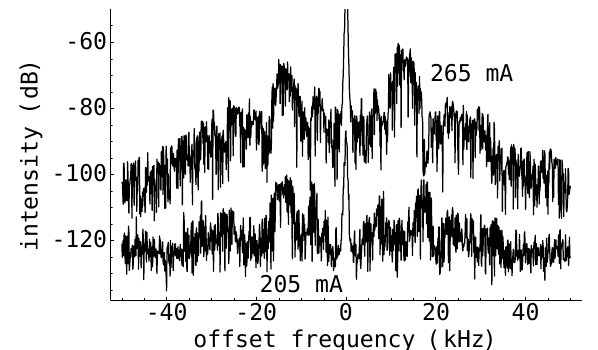
FIG. 2. Measured synchrotron sidebands of stretched single- bunch VUV beams at two beam currents about the 135th revo- lution harmonic. Machine parameters are given in Table I.